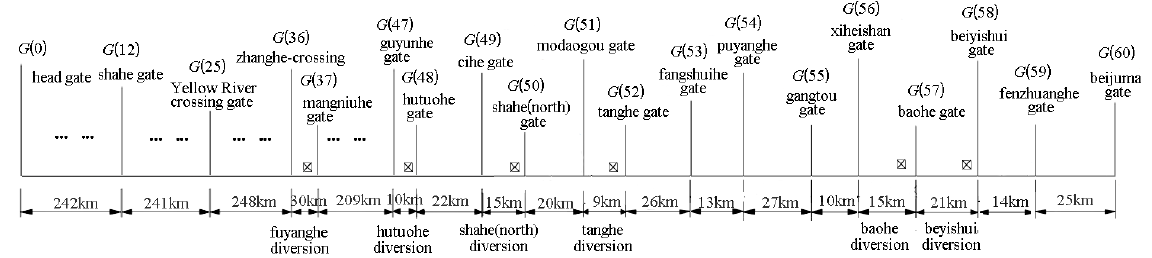
Figure 5. Locations of the main control structures.